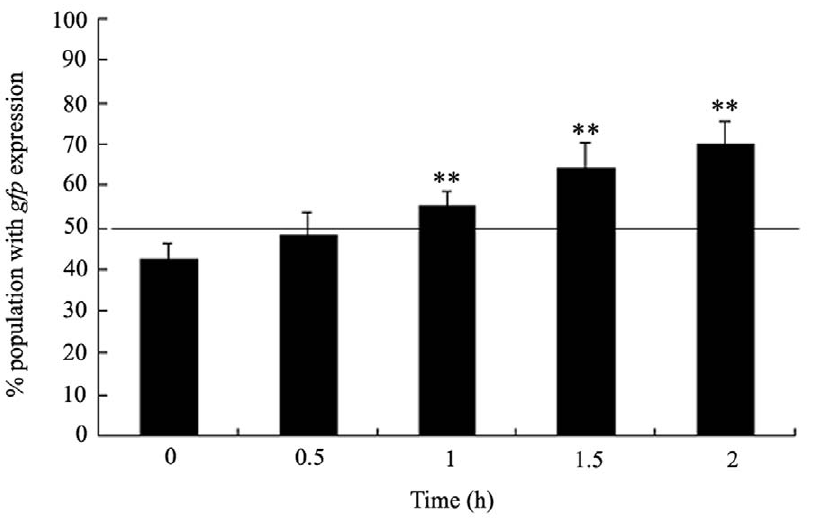
Figure 2. Stress response in heat-shock treated wild-type N2 nematodes. L4-stage larvae animals were heat stressed for 0.5, 1, 1.5, 2 h at 36 u C. To evaluate the stress response, significant induction of hsp-16.2 :: gfp expression (50% of a population, above the line) was observed in wild- type N2 animals. Bars represent means 6 S.D. * p , 0.05 vs 0 h; ** p , 0.01 vs 0 h.